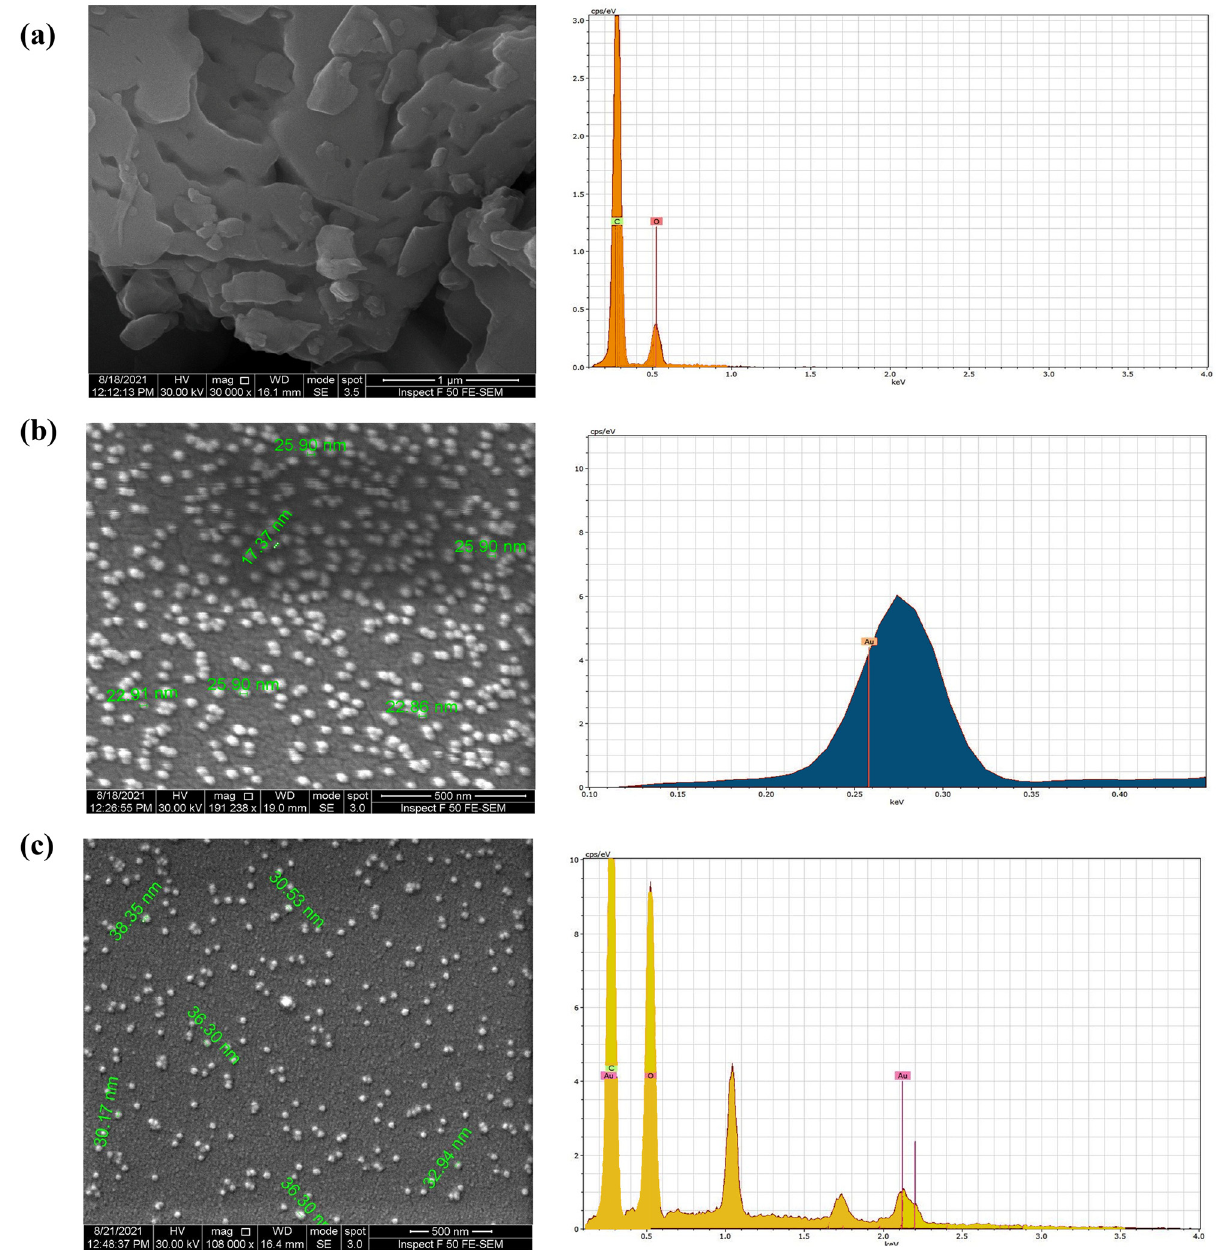
Figure 6: FE - SEM, and energy dispersive analysis ( EDX ) : ( a ) CHR, ( b ) AuNPs, and ( c ) CHR –